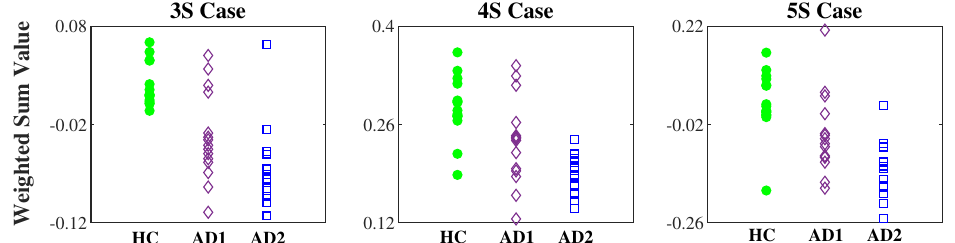
Figure 4. The weighted sum values of the 45 EEG signals recorded from the optimal electrode for the 3S–5S cases. The 15 circle, 15 diamond, and 15 square symbols are from 15 HC, 15 AD1, and 15 AD2 subjects,